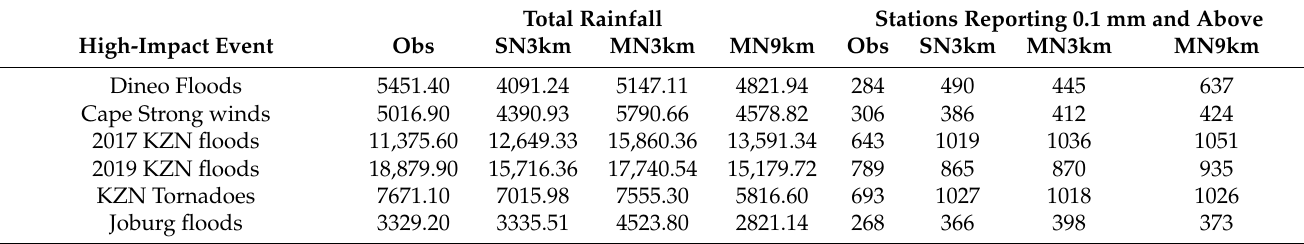
Figure 5. Observed and simulated ( a ) total twenty-four hour rainfall summed across all stations, ( b ) maximum twenty-four hour rainfall , and ( c ) stations that reported more 0.1 mm of rain in a twenty-four hour period. Table 3. The twenty-four hour rainfall summed across all the stations that reported rainfall in columns 2 to 5 and number of stations that reported more than 0.1 mm of rainfall in columns 6 to 9, for observations, the different CCAM configurations and for the six